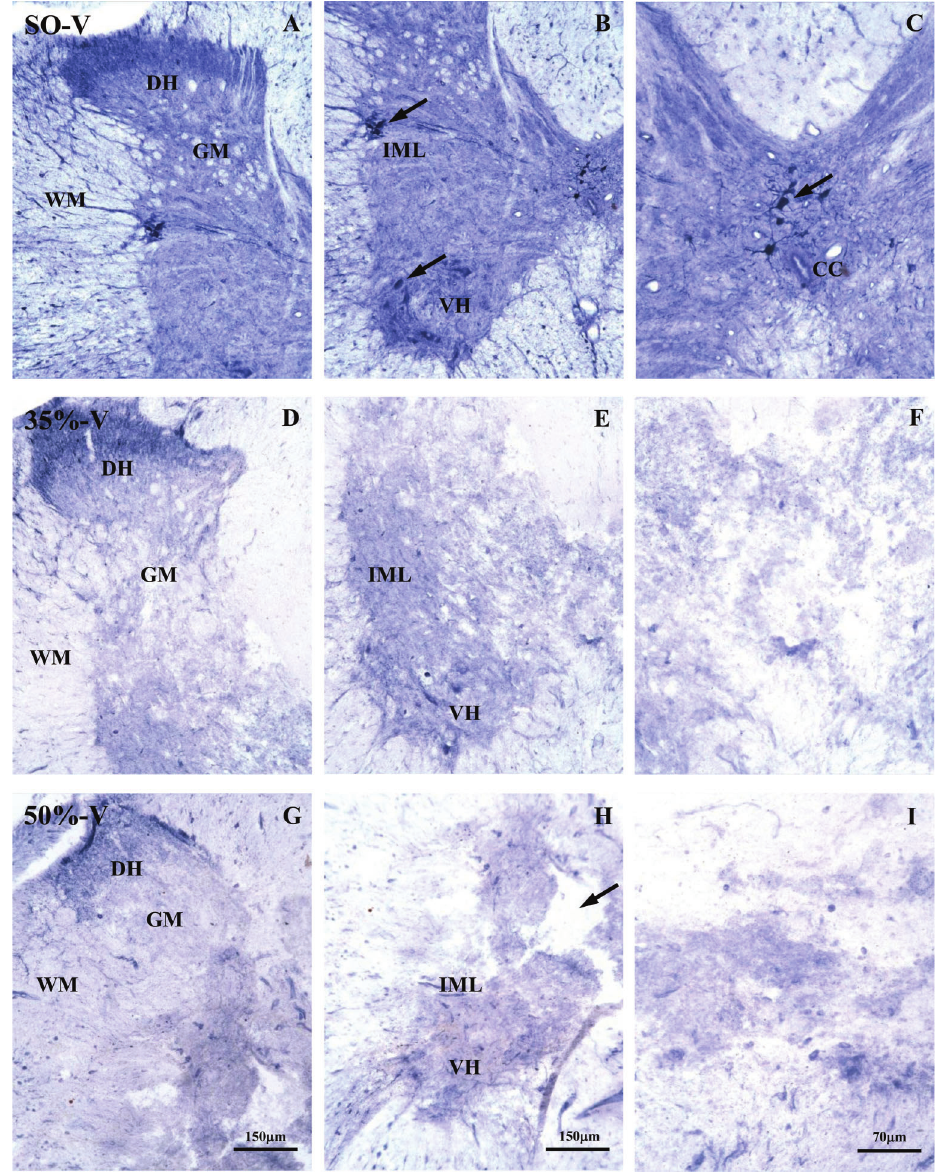
Figure 6. Photomicrograph of a typical thoracic spinal cord segment labeled by NADPH-d activity 35 days after the experimental procedure for the sham-operated ++ vehicle (SO-V) group ( A , B and C ), the narrowing of 35% ++ vehicle (35%-V) ( D , E and F ) group and the narrowing of 50% ++ vehicle (50%-V) ( G , H and I ) group. D-I photomicrographs confirmed the severity of the spinal cord lesion. Arrows in B highlight NADPH-d-positive neurons in the intermediolateral nucleus and in the ventral horn from gray matter. The arrow in C highlights NADPH-d-positive neurons in lamina X of Rexed from gray matter. The arrow in H shows formation of a cavity near the central part of the spinal cord between white and gray matter. DH = dorsal horn; GM = gray matter; VH = ventral horn; WM = white matter; IML = intermediolateral nucleus; CC = central